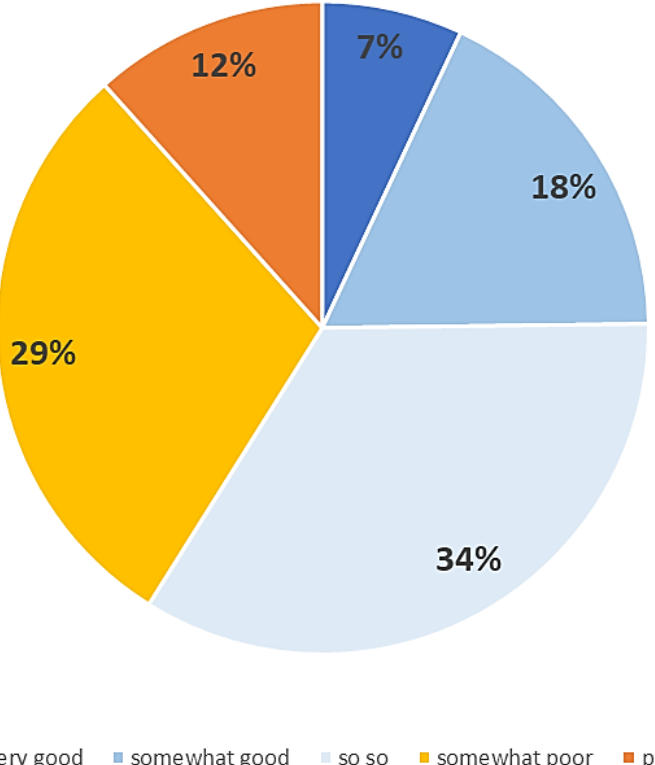
Figure 7. Visibility of the Geopark Swabian Alb ( n = 129) (Author’s design; data basis [68]).